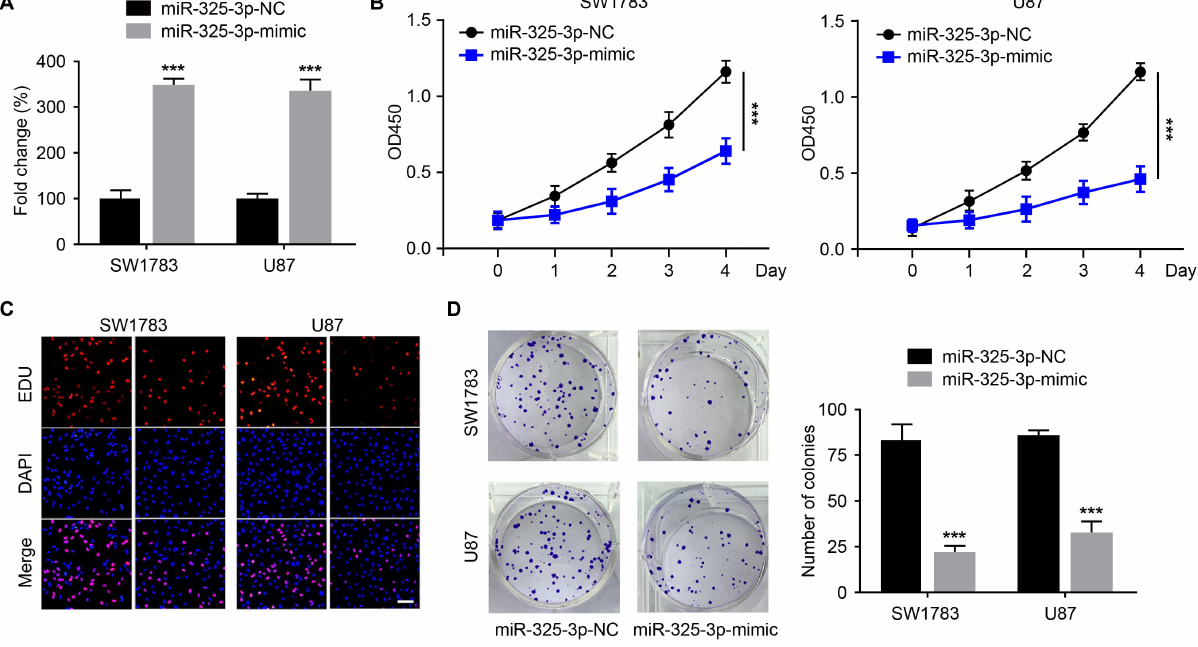
Fig. 3. In vitro upregulation of miR-325-3p inhibits cell growth. (A) The transfection efficiency of miR-325-3p was evaluated using RT-qPCR. (B) Cell viability of SW1783 and U87 cells transfected with the miR-325-3p-mimic was evaluated by CCK8 assay. (C) EDU assay was conducted to examine proliferation. (D) Colony formation assay for the detection of proliferation. Data are presented as the mean ± SEM, *** p < 0.001, compared to the miR-325- 3p-NC